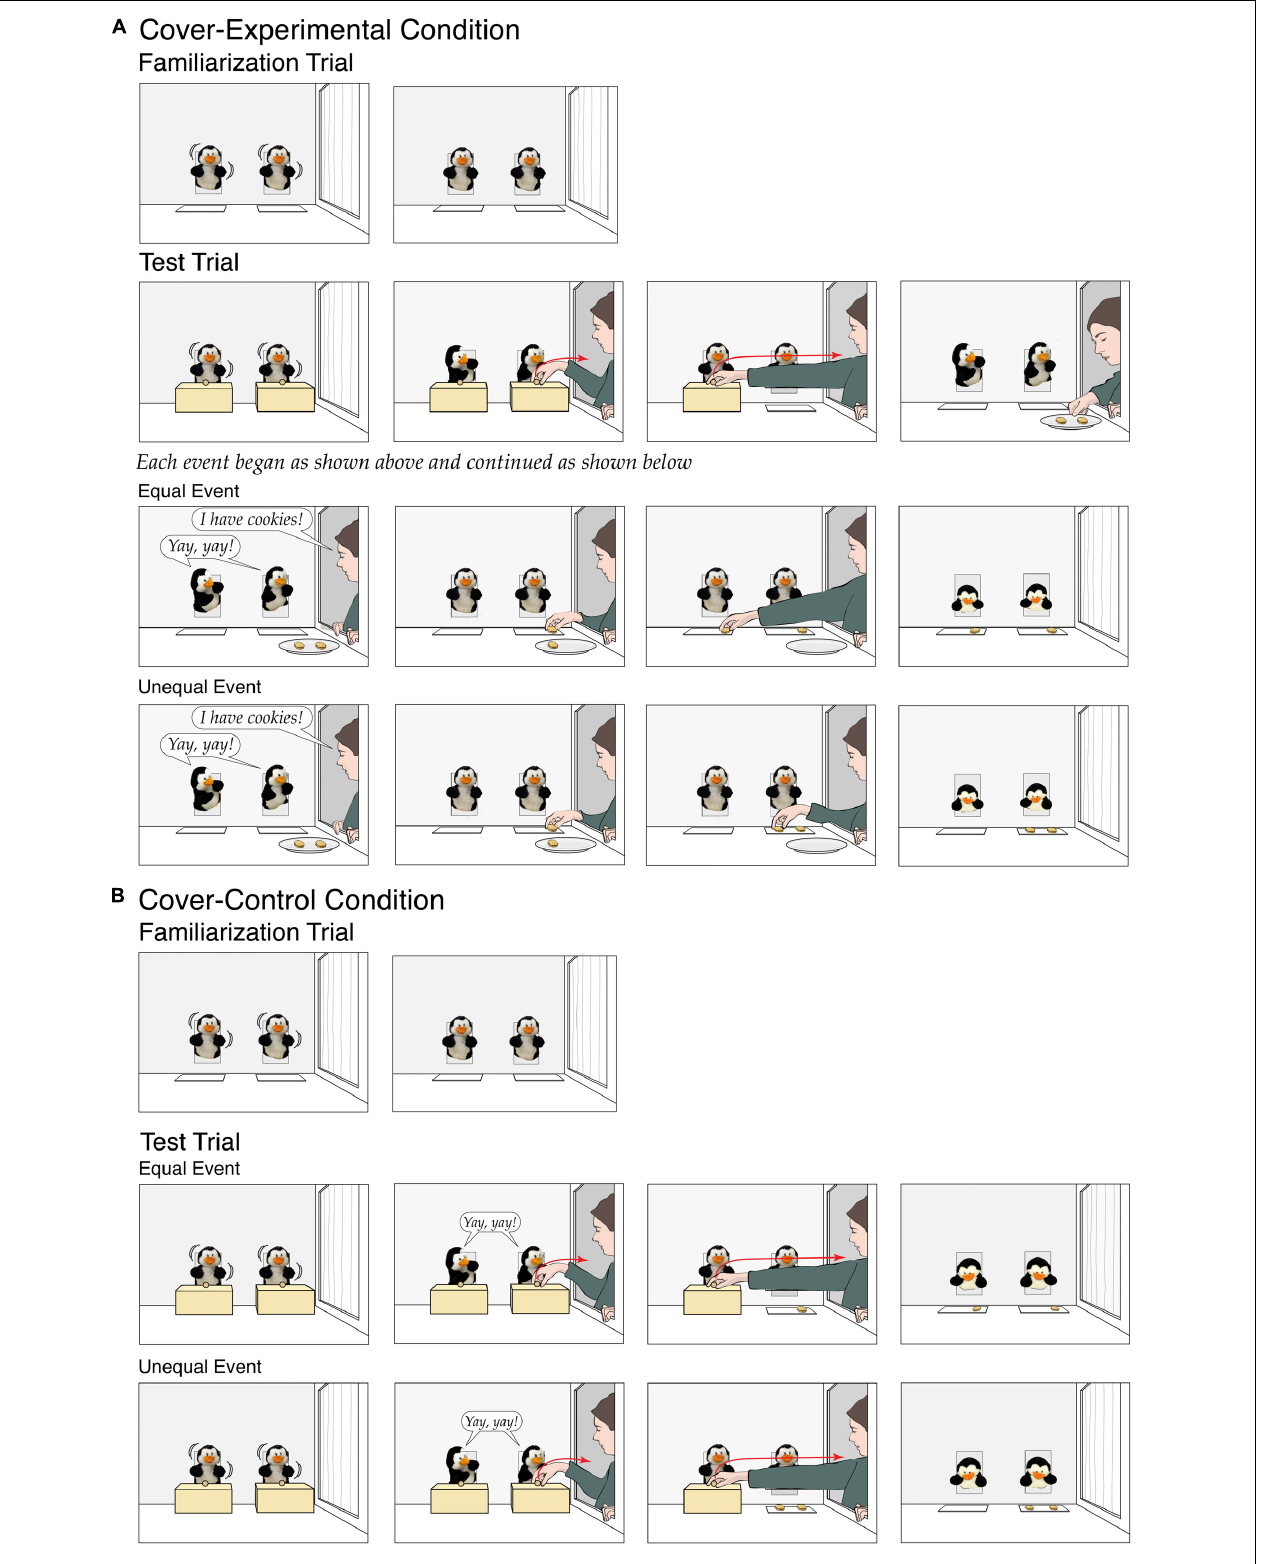
FIGURE 3 | Schematic depiction of the events shown in the cover-experimental condition (A) and the cover-control condition (B) of Experiment 2.